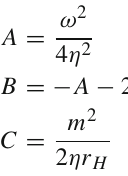
three figures we fix r H = 2 and η = 0 . 25. In each figure we show three different curves corresponding to: (1) ξ = 0 . 100 (solid black line), (2) ξ = 0 . 125 (dashed blue line) and (3) ξ = 0 . 150 (dotted-dashed red